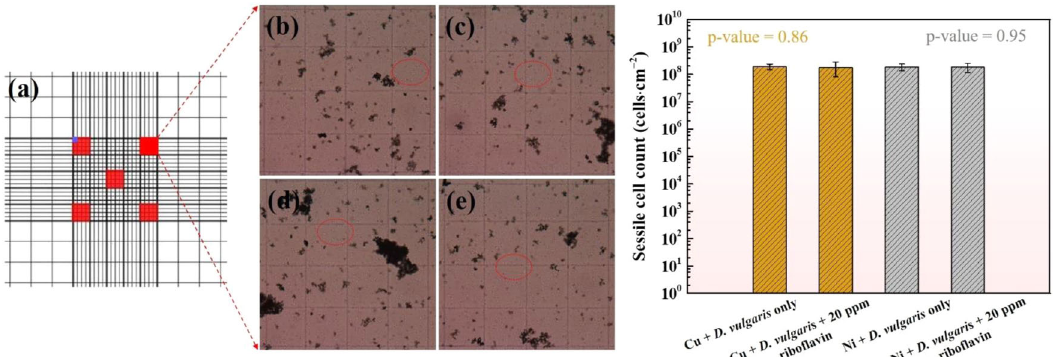
Fig. 1 Optical micrographs of D. vulgaris and sessile D. vulgaris cell counts. Schematic diagram of counting chamber ( a – e ) correspond to sessile D. vulgaris on the blood cell counting plate (motile D. vulgaris underlined as white spots in red circles), and sessile D. vulgaris counts after the 7-d incubation: b Cu + D. vulgaris only; c Cu + D. vulgari s + ribo fl avin; d Ni + D. vulgaris only; e Ni + D. vulgari s + ribo fl avin. (Error bars stand for the standard deviations from at least three independent